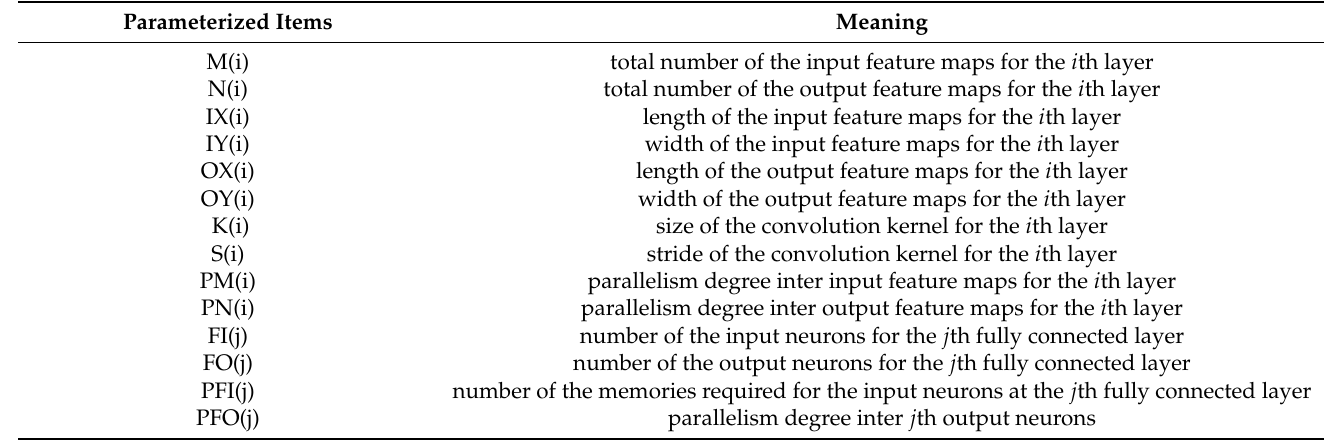
Table 1. Parameterized items of RTL modules in the hardware